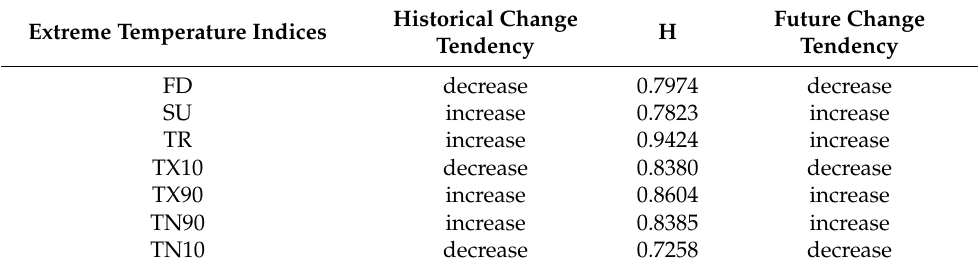
Table 3. The forecast of trends of extreme temperature